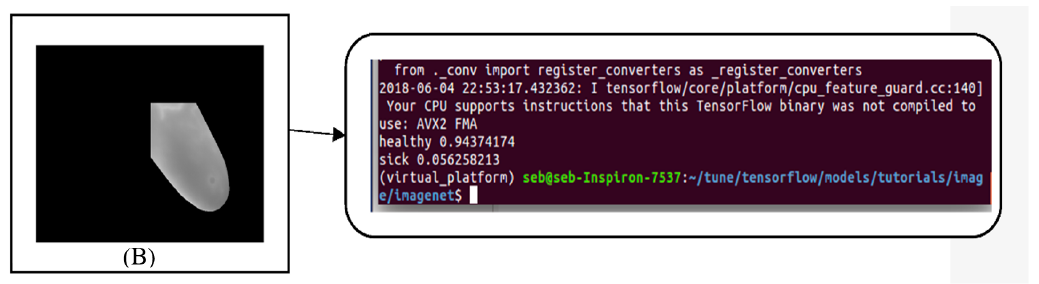
Figure 19. Given image ( B ) as input, our model classifies the image as “healthy” with a confidence of